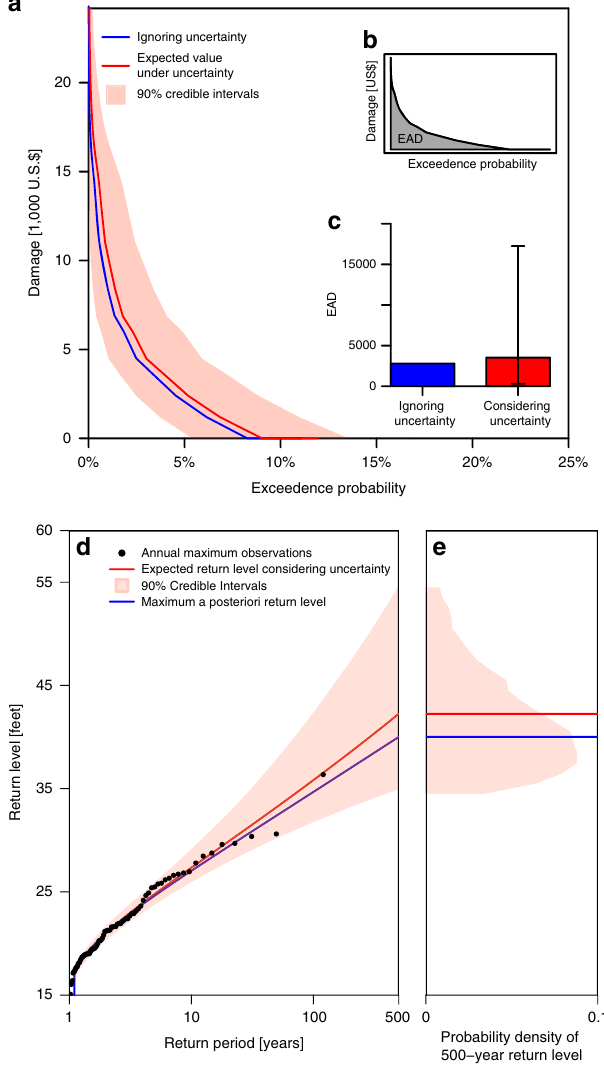
Fig. 1 Impact of uncertainty on fl ood hazards and damages. a Exceedance probability loss curves under the considering-uncertainty (red line and bounds) and ignoring-uncertainty (blue line) assumptions. The shaded red area indicates the 90% credible intervals of the considering-uncertainty assumption. b Expected annual damages (EAD) is the area under the exceedance probability loss curve that indicates damage versus fl ood probability. c The resulting EADs are compared in this panel. The narrow line on the red bar indicates the range of uncertainty in EAD. d Return levels of the two assumptions are compared. e Comparison of the distribution of 500-year fl ood under uncertainty (red line and shaded area) with the 500- year fl ood estimate under the ignoring-uncertainty the time value of money, which is related to the interest an alternative investment would have yielded. For the house elevation problem, relevant and relatively safe investment opportunities on decadal time scales are U.S. Treasury bonds.